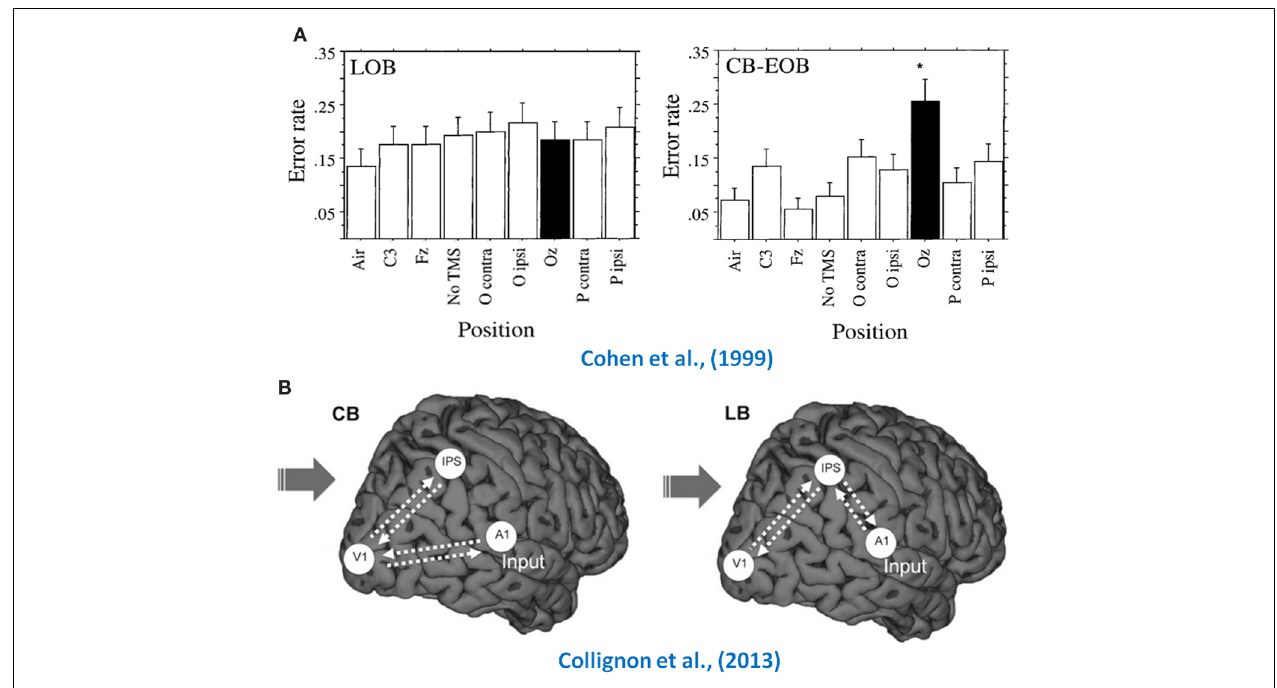
FIGURE 3 | How early and late blind differ. Illustrated here are two examples of how the crossmodal plasticity observed in early and late blind individuals differs. The top row (panel A ) illustrates the differential effect TMS has when applied over the occipital cortex (black bars) of LB (first bar graph) and EB (second bar graph) on their performance in a Braille task, where only